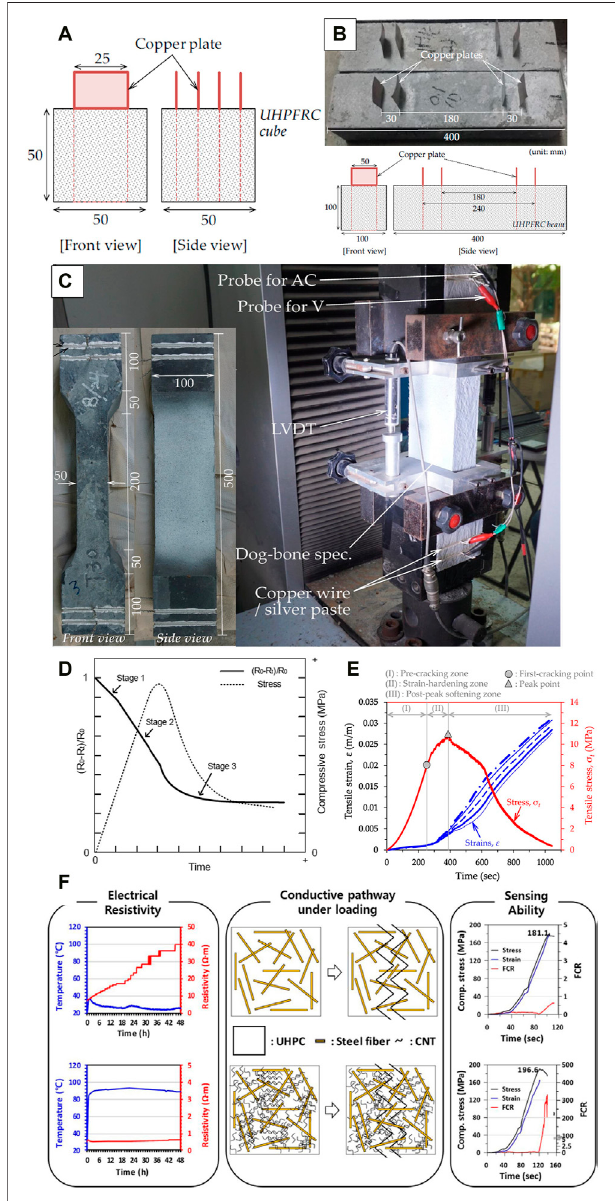
FIGURE1| Typicalloadingconditionsand measurement ofself-sensing capacity of UHPC. (A) compressive loading (You et al., 2017); (B) fl exural loading (You et al., 2017); (C) direct tensile loading (Yoo et al., 2018); (D) typical electromechanical response under compression (Kim et al., 2021); (E) tensile stress- and strain-time behaviors of UPFRC with CNTs (Yoo et al., 2018); (F) typical cracking sensing (Jung et al.,